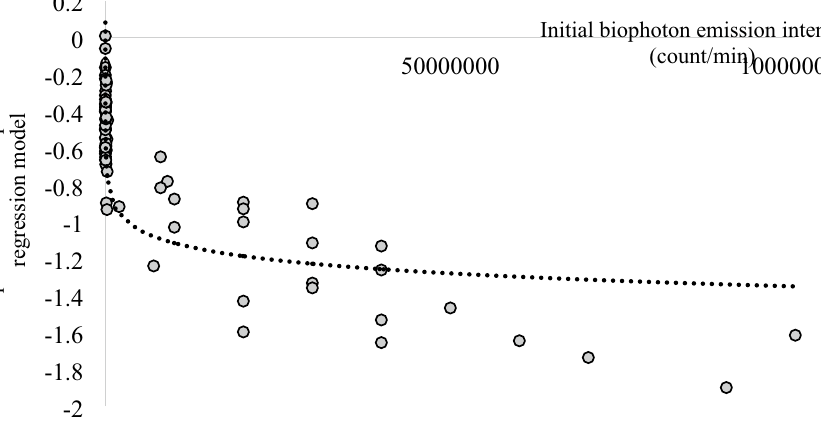
Figure 4. Logarithmic regression model was used to determine the relationship between initial biophoton emission intensity (count/min) and the dynamics of the change in biophoton emission intensity over time (i.e. slope of the fitted exponential regression model) in two experimental groups (Control and Biotic-stressed groups) on Leaf A.